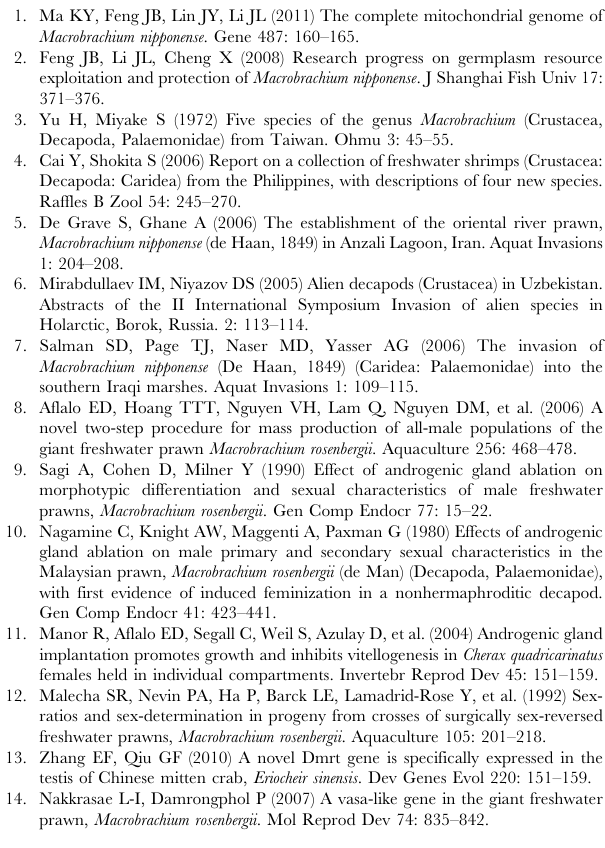
Table S1 Summary of BLASTx results for contigs and singletons of M. nipponense . Table S2 Categories of Gene Ontology of M. nipponense unique sequences. Table S3 KEGG summary of M. nipponense unique sequences. Table S4 Summary of putative SSRs and SNPs from